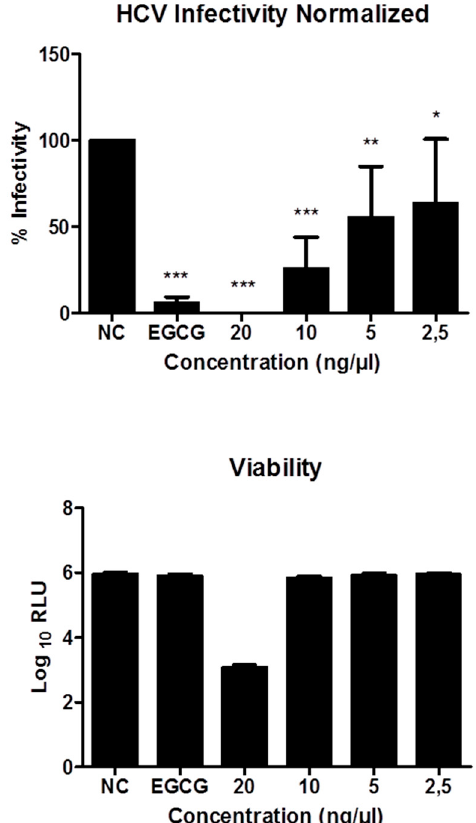
Figure 4. Antiviral activity of 4-hydroxypleurogrisin ( 11 ). NC-Negative control, EGCG-Positive control. HCV assay was performed in triplicates and is presented as the mean ± standard deviation. The asterisk indicates statistically significant differences (* p ≤ 0.05, ** p ≤ 0.01, *** p ≤ 0.001). Huh-7.5 cells were inoculated with RLuc-Jc1 reporter viruses in the presence of 4-hydroxypleurogrisein. The inoculum was removed 4 h later and monolayers were washed three times with PBS and overlaid with fresh medium containing no inhibitors. Infected cells were lysed three days later, and reporter virus infection was determined by renilla luciferase activity ( top ). The cell viability was measured by determination of firefly luciferase ( bottom ), which is stably expressed in the target cells. 3. Materials and Methods 3.1. General 1D and 2D-NMR spectra were recorded on a Bruker Avance III 500 MHz spectrometer (Bremen, Germany) with a BBFO(plus) SmartProbe ( 1 H 500 MHz, 13 C 126 MHz), and a Bruker Avance III 700 MHz spectrometer (Bremen, Germany) with a 5 mm TCI cryoprobe ( 1 H 700 MHz, 13 C 175 MHz). Chemical shifts were referenced to the solvents: chloroform- d ( 1 H, δ = 7.27 ppm; 13 C, δ = 77.0 ppm) and acetone- d 6 ( 1 H, δ = 2.05 ppm; 13C, δ = 29.3 ppm). HRMS mass spectra were measured on the Agilent 1200 series HPLC-UV system (Santa Clara, CA, USA) combined with ESI-TOF-MS (Maxis, Bruker, Bremen, Germany), scan range 100 − 2500 m / z , capillary voltage 4500 V, temperature 200 °C, (column 2.1 × 50 mm, 1.7 µm, C18 Acquity UPLC BEH [Waters, MZ-Analysetechnik, Mainz, Germany], solvent A: 95% 5 mM ammonium acetate buffer [pH 5.5, adjusted with 1 M acetic acid] with 5% acetonitrile; solvent B: 95% acetonitrile with 5% 5 mM ammonium acetate buffer); gradient: